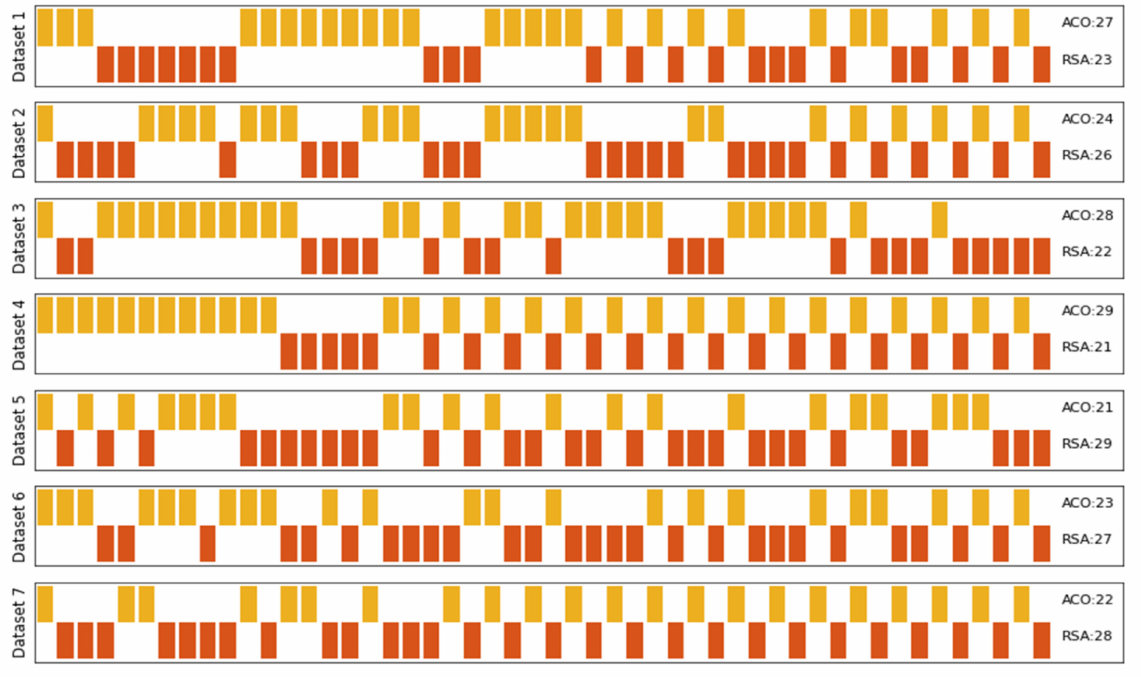
Figure 4. Switching behavior of proposed ACO-RSA for sample runs using all seven